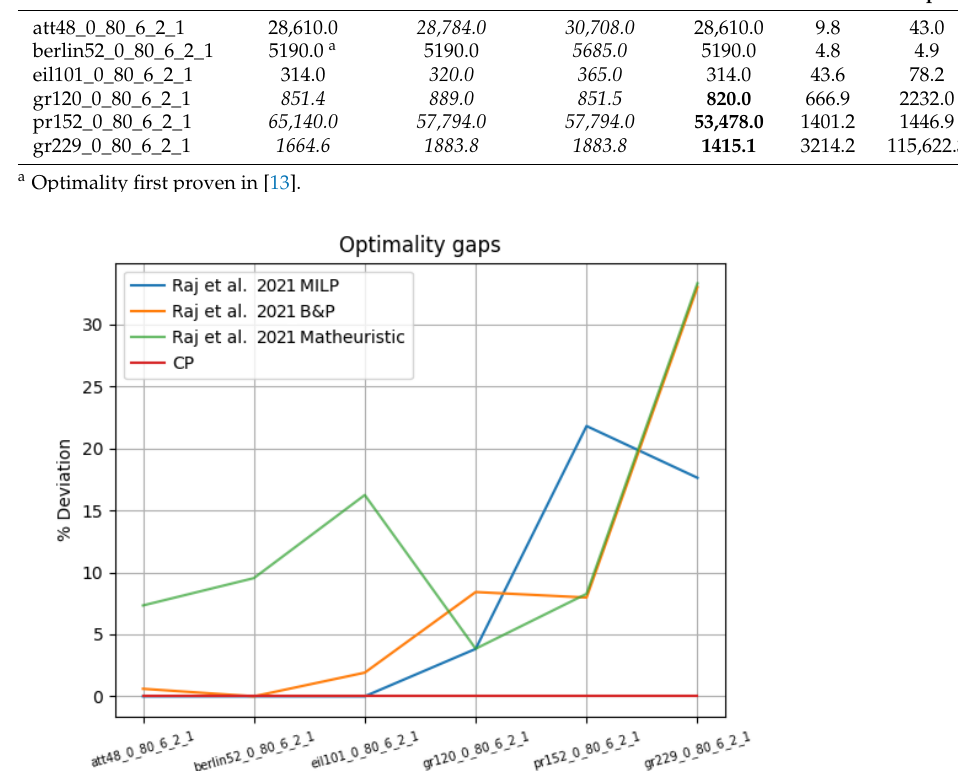
Figure 4. Optimality gap for the different methods tested on the instances proposed in